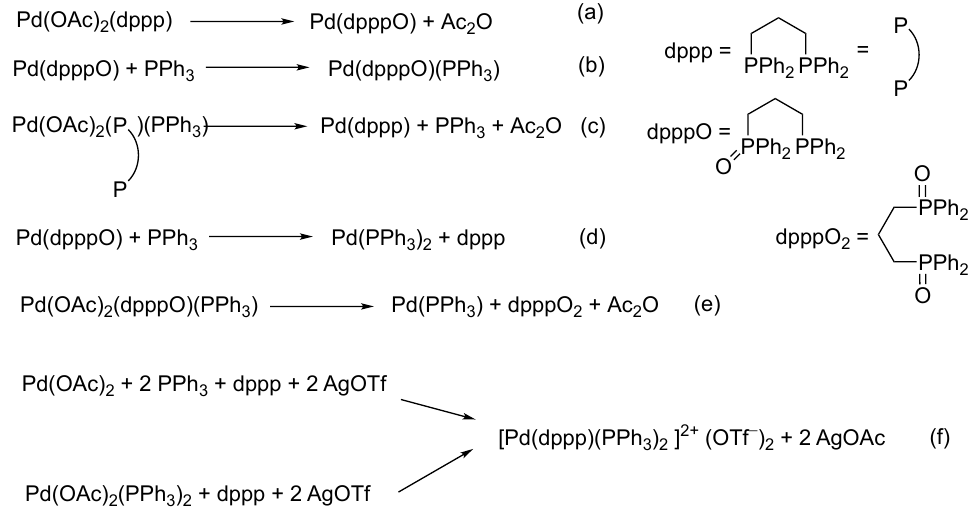
Figure 3. Formation of Pd(0) species from Pd(II) precursors ( a – e ), and that of the cationic Pd(II) complex in the presence of diphosphine, monophosphine and silver triflate ( f